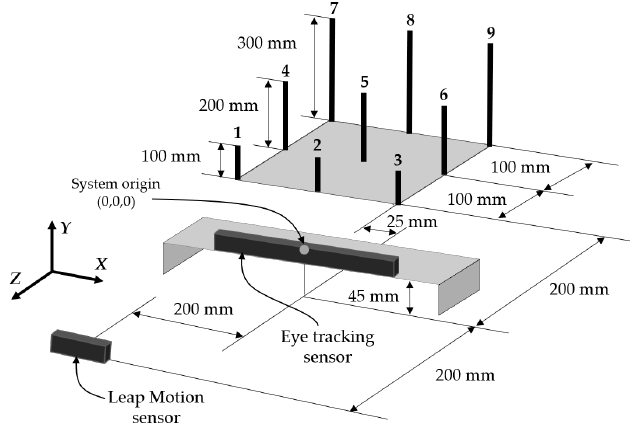
Figure 22. Experimental equipment